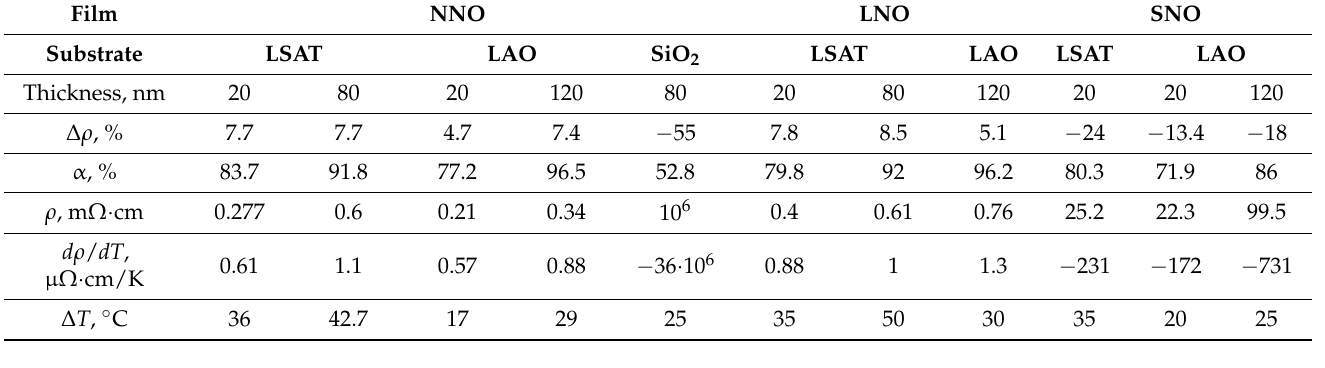
Figure A4. ( a ) Resistivity temperature dependence for other tested SNO films: two 20-nm thick films deposited on LSAT and LAO and a 120-nm thick film on LAO. ( b ) Percentage change of their room-temperature resistivity at long-term illu- minations by the blue laser at optical power 0.8 W Table A1. Photoresistivity parameters for all tested films at T = 26 °C and the reference blue light illumination of 0.8 W power: percentage changes of the resistivity Δ ρ , the measured absorption factors α of the film-substrate stacks, resistivity values ρ , derivatives d ρ /dT and estimated rises of the film temperature Δ T .